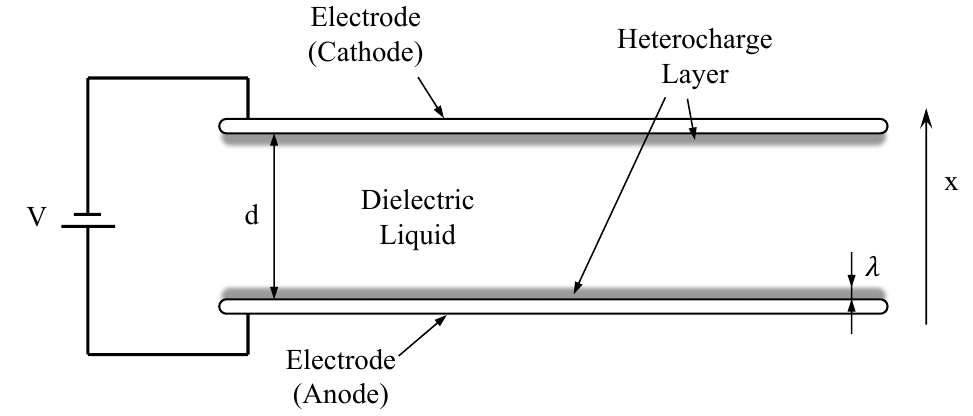
Figure 3. Parallel electrodes in dielectric liquid. V is the direct current (DC) supply, d is the electrode spacing, λ is the thickness of the heterocharge layer, and x is characteristic length for the normalization of the